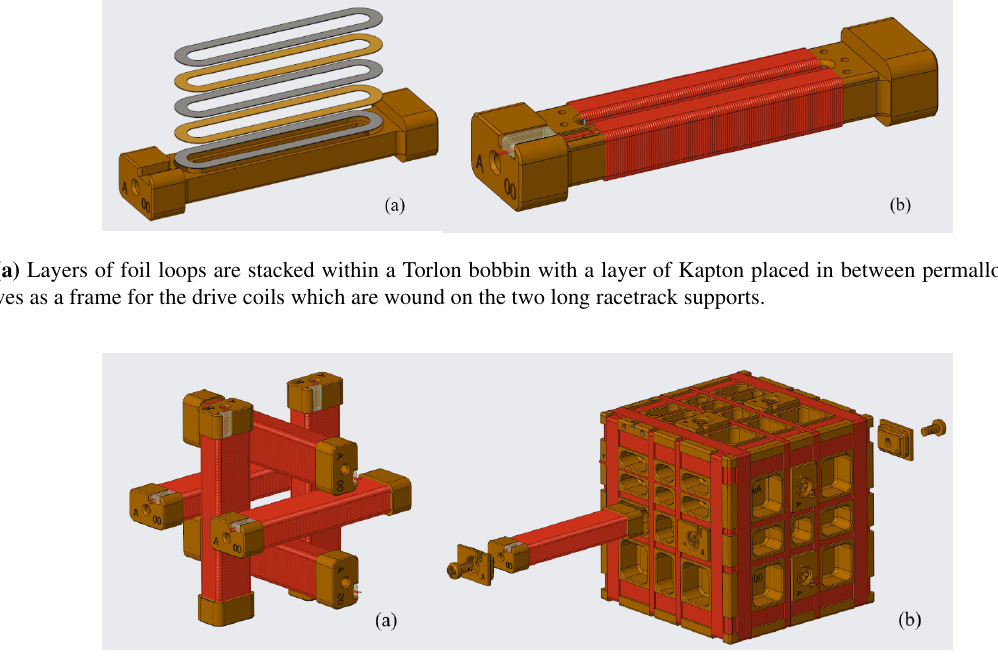
Figure 3. (a) Tesseract’s six miniature racetrack cores are wound with a solenoidal sense winding, arranged in pairs/two per axis and (b) secured within one common Torlon base. The Tesseract sensor’s Merritt coil feedback windings are wound in small, machined channels in this